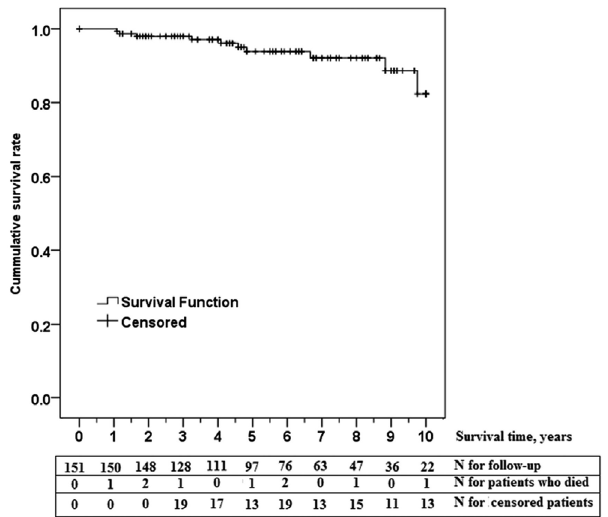
Fig. 4 – Kaplan-Meier curve showing cumulative survival of patients